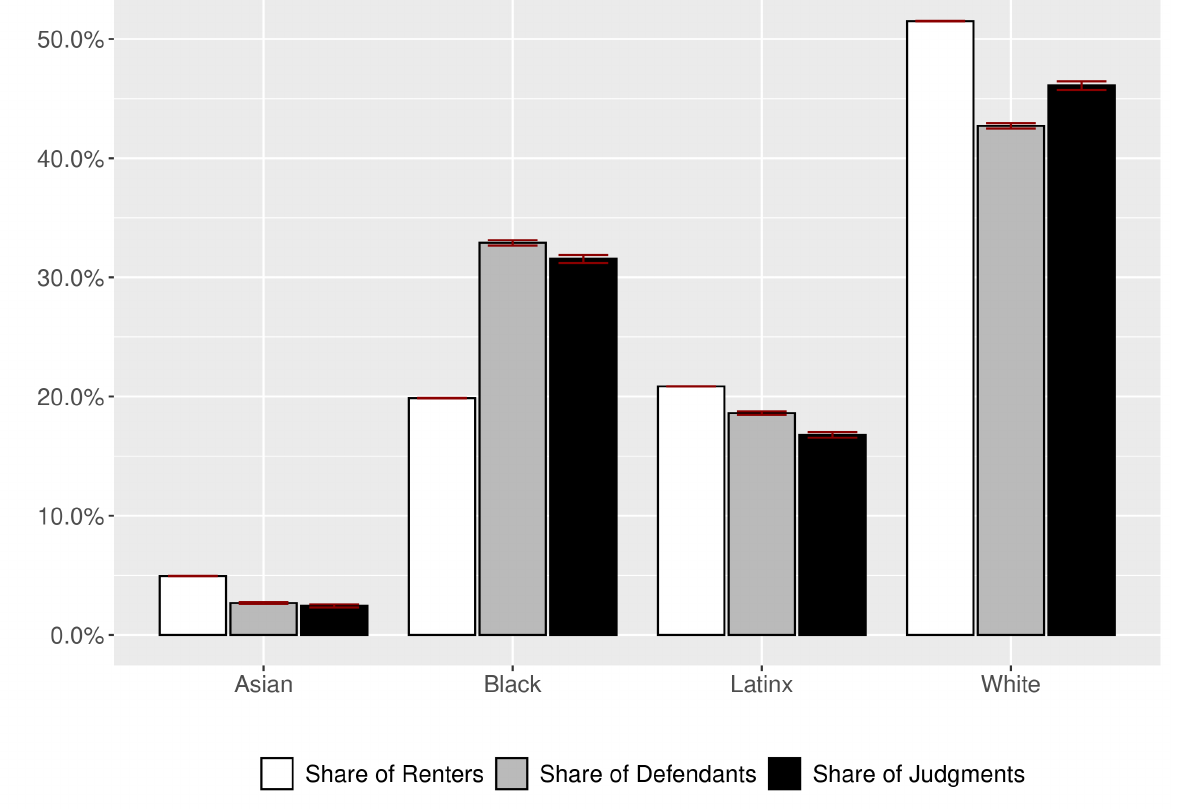
Figure 1: Share of all renters, eviction filings, and eviction judgments, by race/ethnicity. Error bars indicate 95 percent confidence